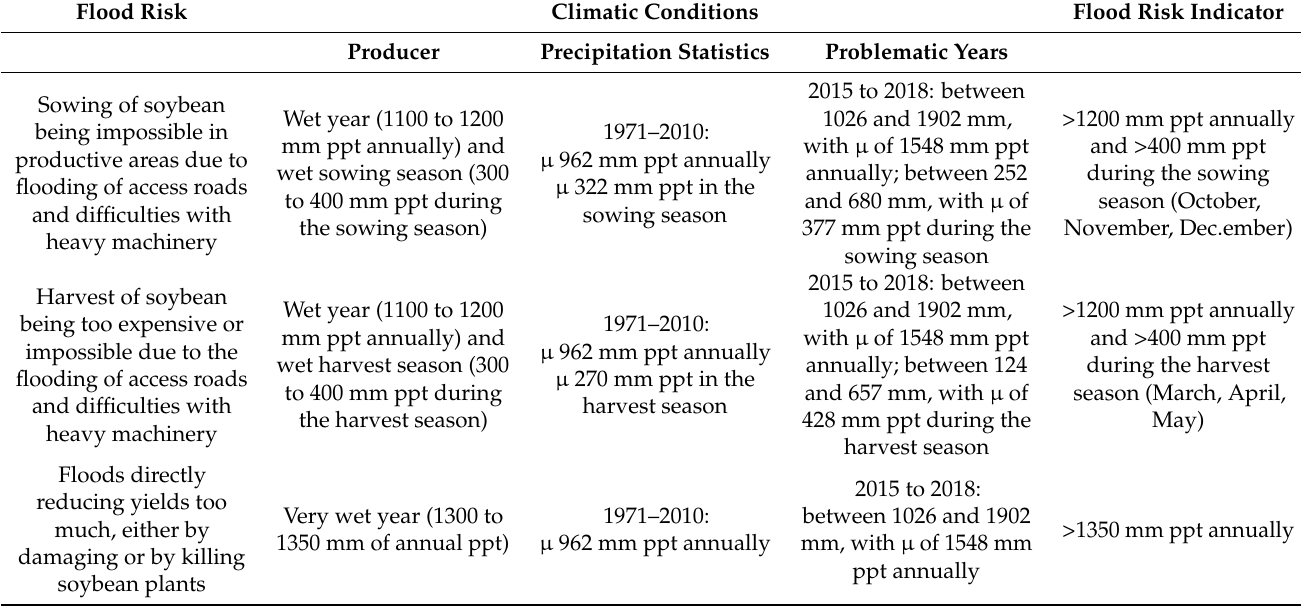
Table 2. Climatic conditions supplied by producers and assessed using historical precipitation observations for the impact of slow-onset floods on soybean production in the DGL, whereby µ stands for ‘mean’ and ppt stands for